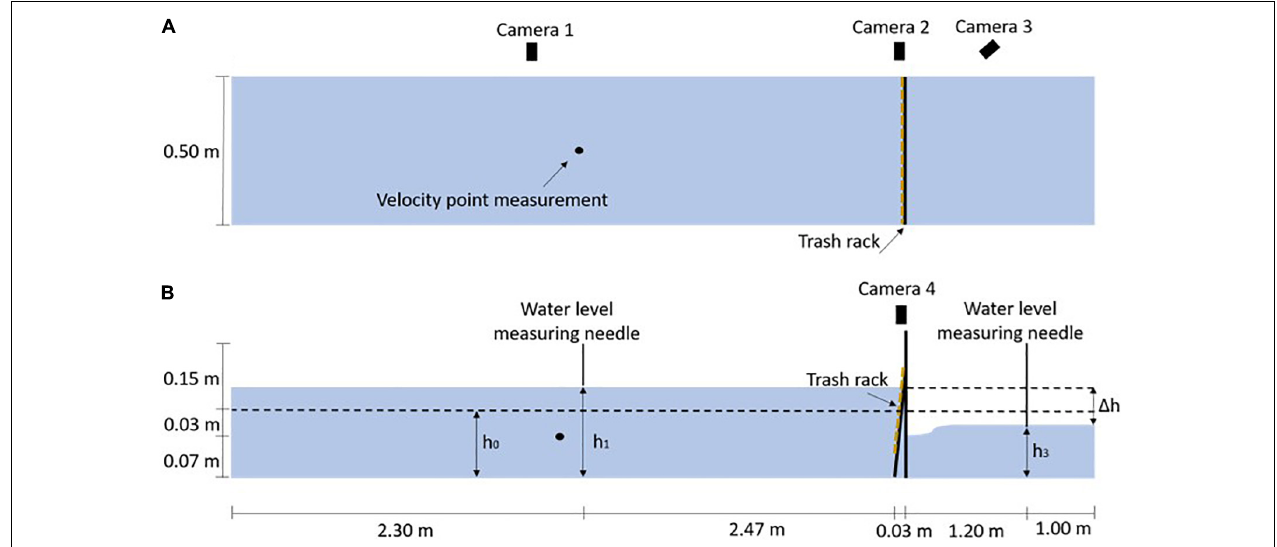
FIGURE 2 | (A) Plan view of flume set-up and camera arrangement and (B) side view of trash rack. In which h 0 represents the approach water depth, h 1 the upstream water level, and h 3 the downstream water